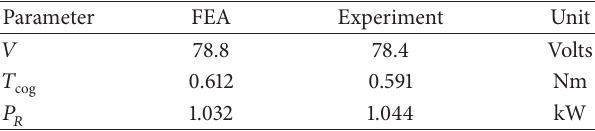
Table 5: FEA and experimental